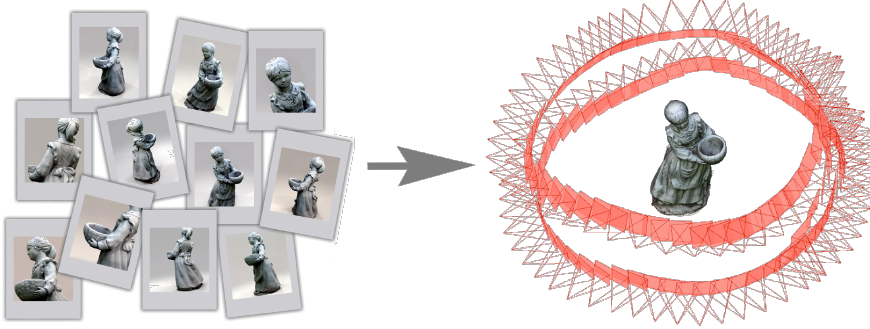
Figure 1. 3D reconstruction using Structure from Motion.